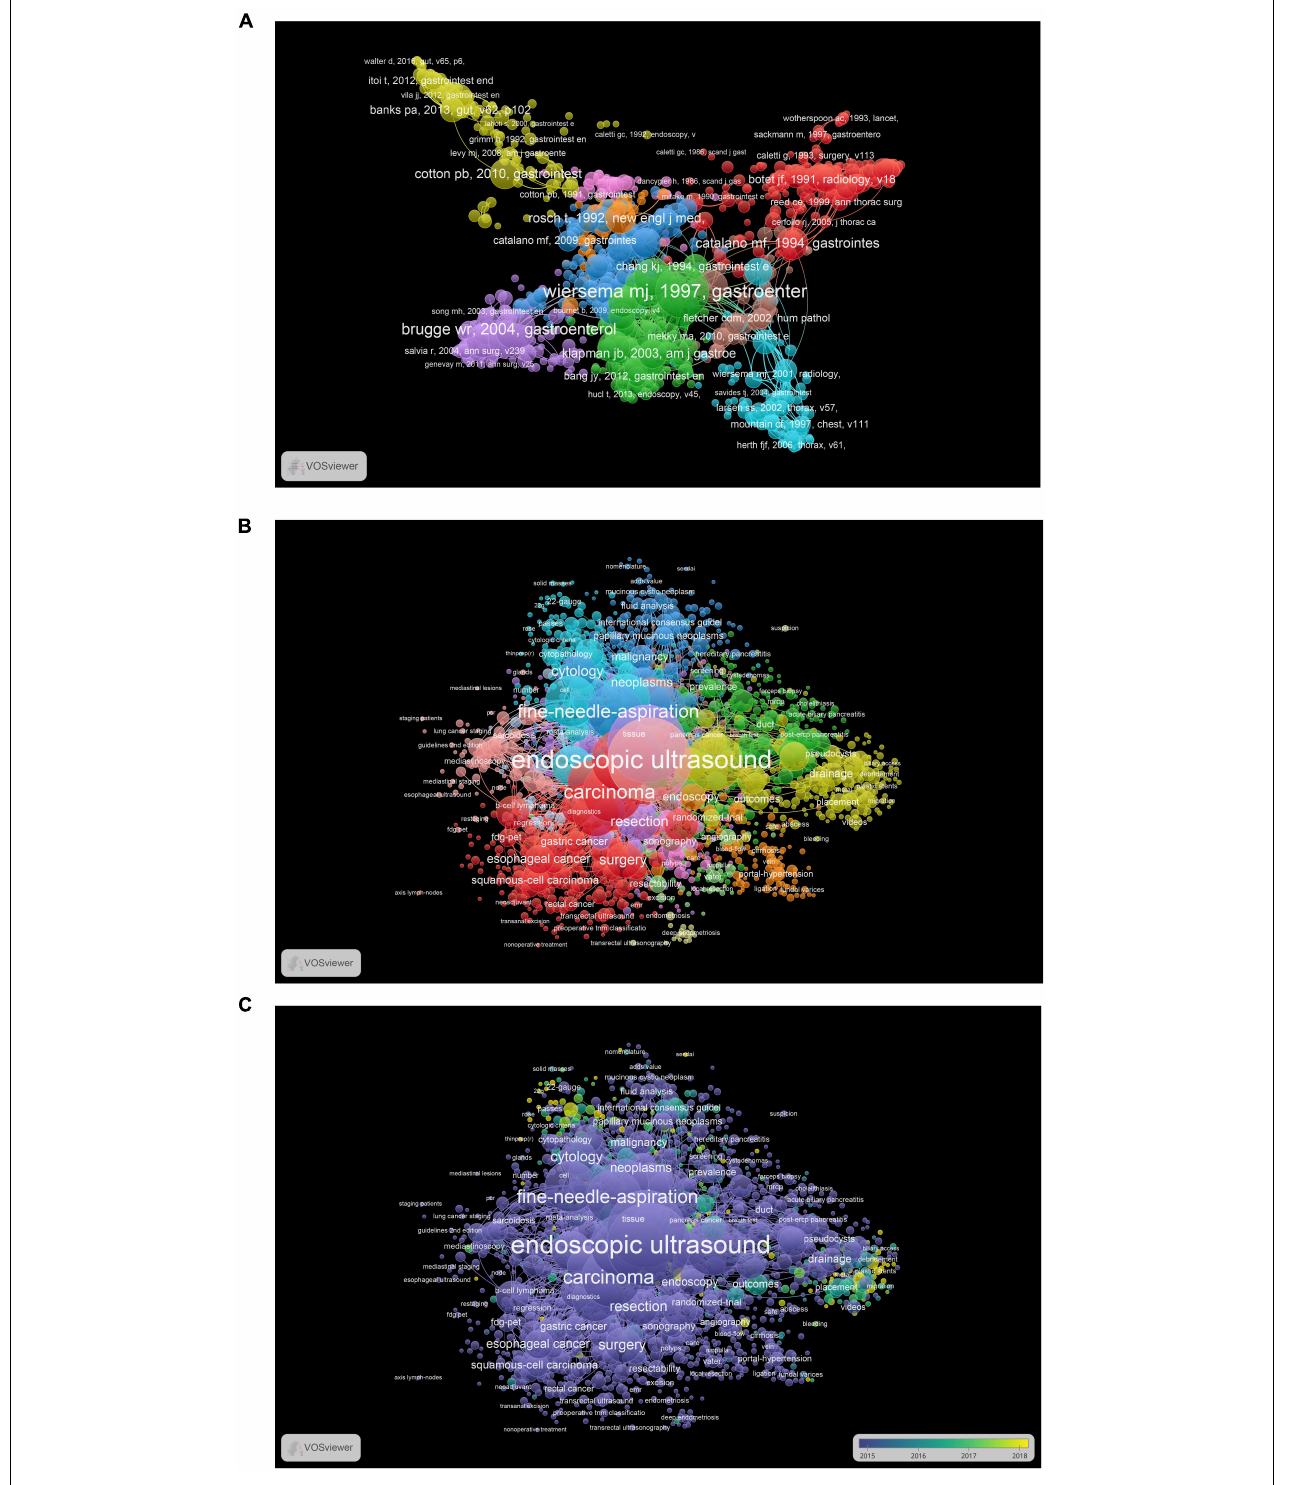
FIGURE 5 | (A) The network map of publications for EUS research. (B) The network map of keywords for EUS research. (C) The network map of keywords for EUS research during 2015–2018, different colors indicating different years.